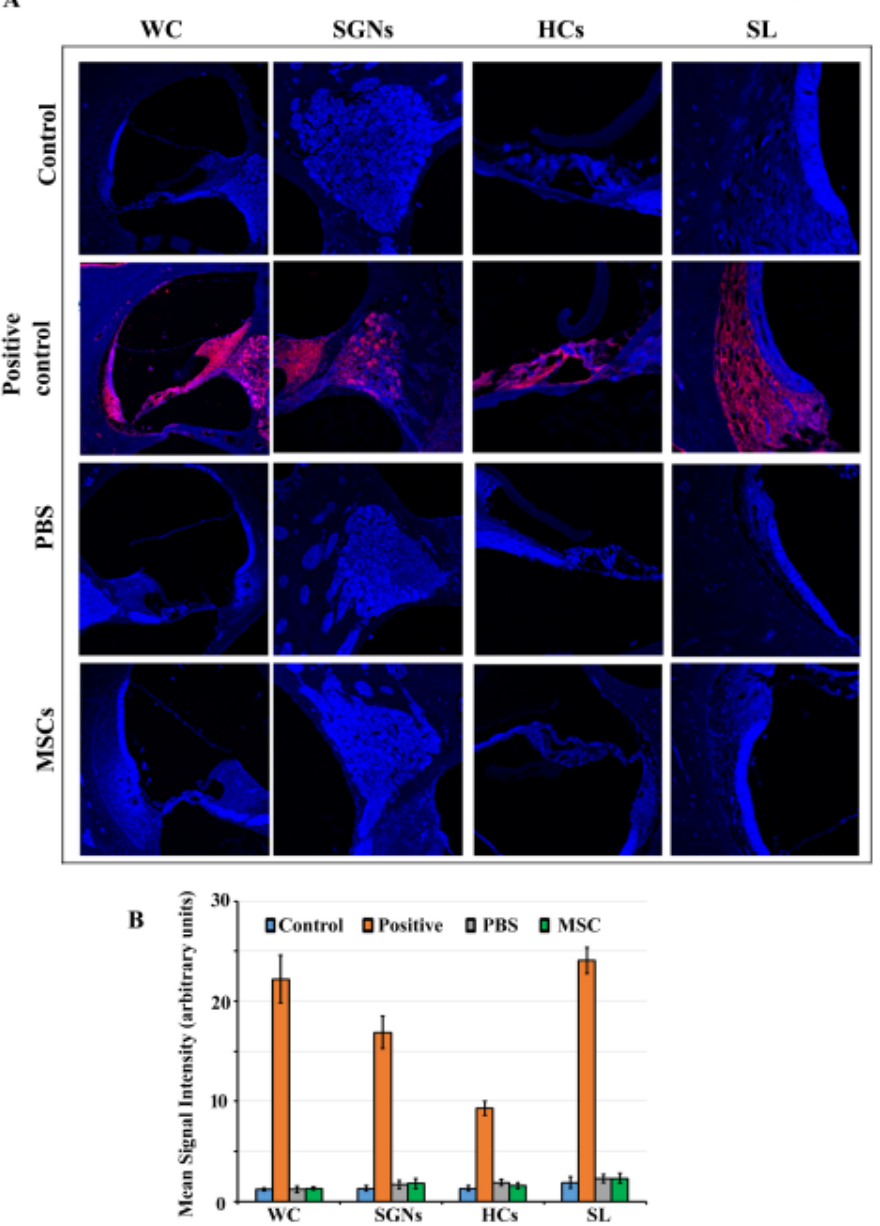
Figure 2. Cleaved caspase 3 immunostaining: ( A ) Rat cochlear slices were subjected to cleaved caspase 3 immunostaining (red) to determine apoptosis. Cell nuclei were stained with DAPI (blue). Cochleae harvested from rats that received BM-MSCs, PBS injected, or control group showed no or sparse staining whereas those from the positive group showed intense staining (red color). Blue color shows DAPI staining. ( B ) Mean signal intensity for cleaved caspase 3 was calculated using Image J software. Data are expressed as mean values ± standard deviation (SD). WC: whole cochlea; SGNs: Spiral Ganglion Neurons; HCs: Hair Cells; SL: Spiral Ligament.